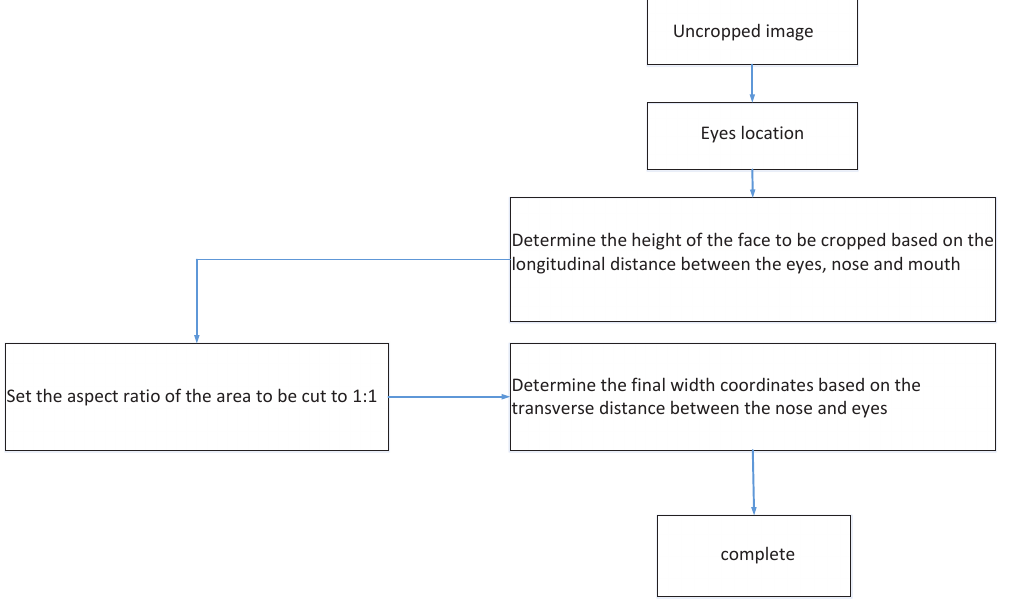
Figure 1. Algorithm to crop face region. An important pre-processing method is used in this paper. Eye orientation is the first step, then other important components are located based on the eye orientation, and finally the picture size scale of face area is set to